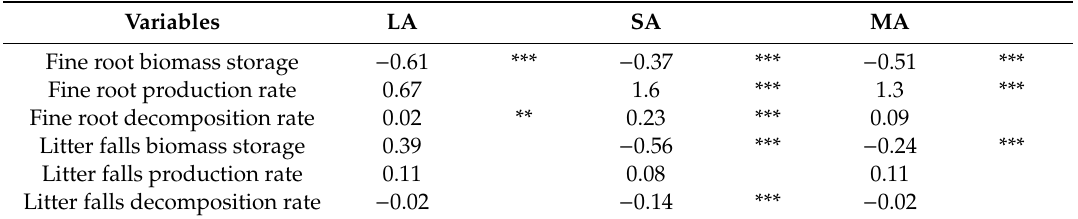
Table 3. Summary of generalized linear mixed models analyses of aggregates carbon